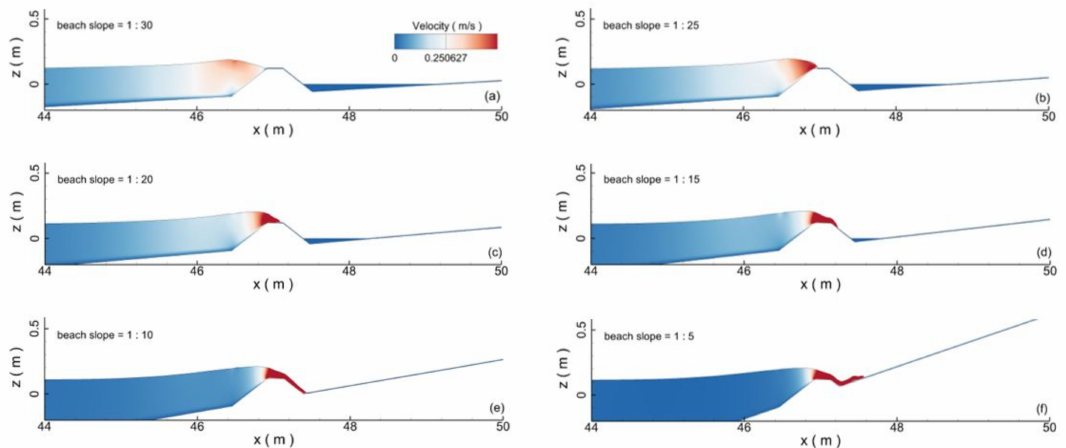
Figure 30. Snapshots of the velocity contours of the water body at the moment of the wave crest climbing over the seawall with different sidewall slopes; ( a ) beach slope = 1:30; ( b ) beach slope = 1:25;